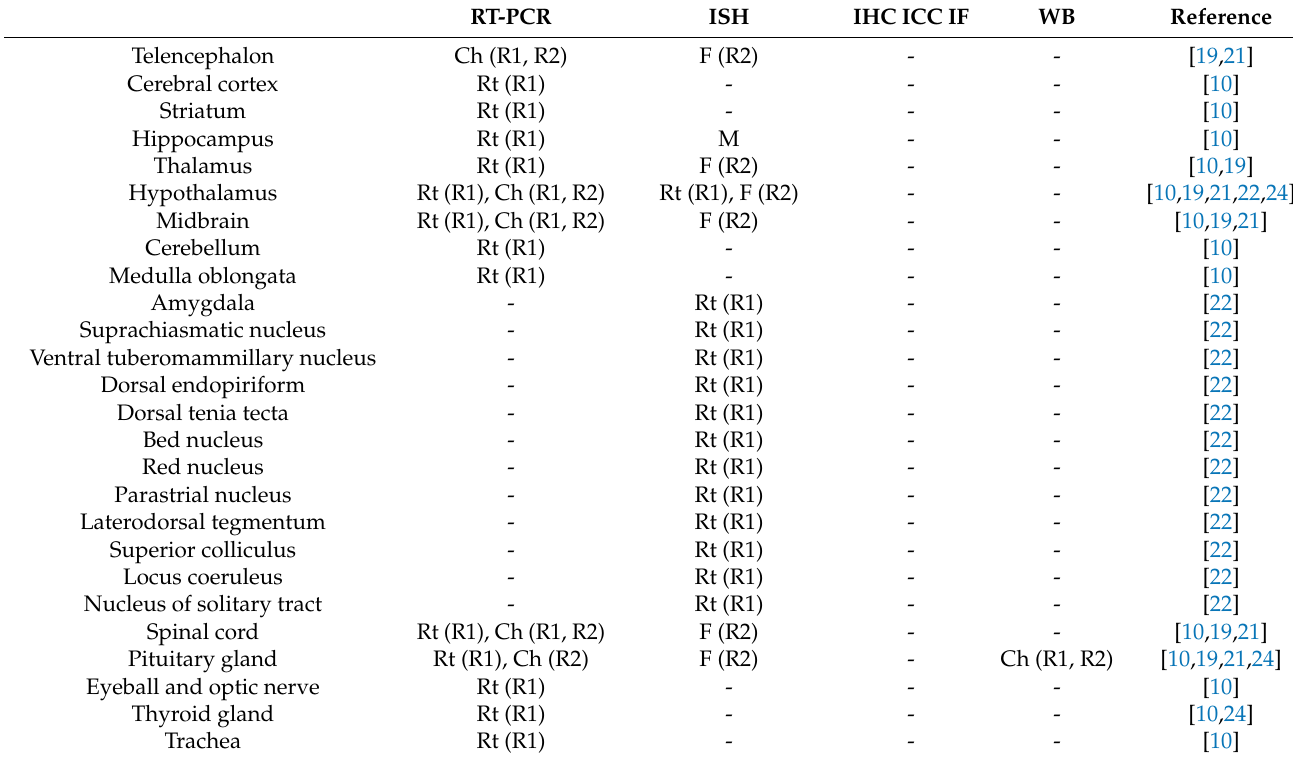
Table 2. Localization of NPBWR1 (R1) and NPBWR2 (R2) in central nervous system and peripheral